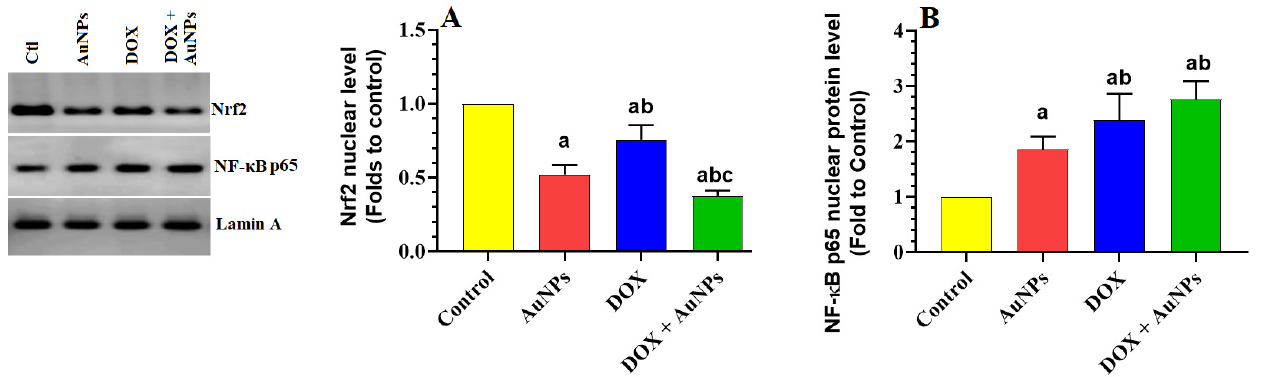
Figure 5. Effects of the individual or combined treatments with gold nanoparticles (AuNPs) and/or doxorubicin (DOX) on the nuclear levels of Nrf2 ( A ) and NF- κ B p65 ( B ) in the liver of all experimental groups. Data were analyzed by 1-way ANOVA followed by Tukey’s test. Values are presented as means ± SD ( n = 8/group). Significance was considered at p < 0.5. a : vs. control rats; b : vs. AuNPs-treated rats; c : vs. DOX-treated